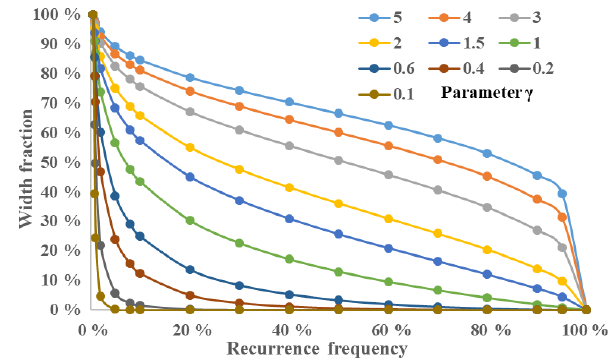
Figure 2. Different river width distributions for different values of the gamma